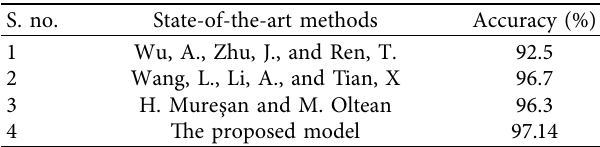
Table 4: Comparison of models with existing techniques. S.